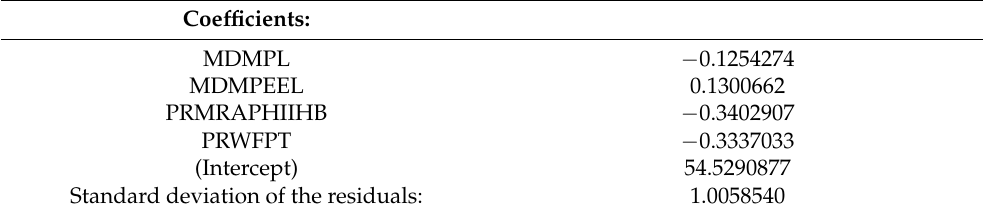
Table 4. Parameters of node “ b uying with mortgage” (Gaussian distribution; conditional density).